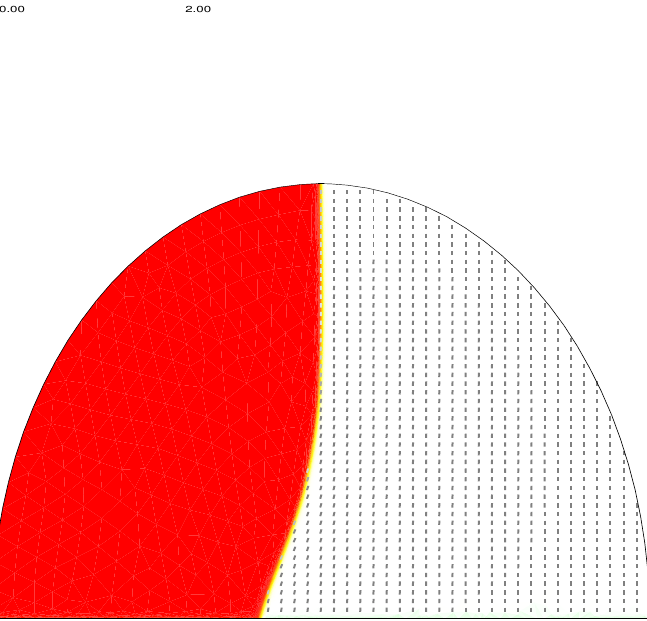
Figure A4. Plot of the nematic order parameter (color code) and nematic director (segments) of a nematic–isotropic interfacial configuration in contact with a substrate with anchoring strength w = 0.10 and R = 160 ξ